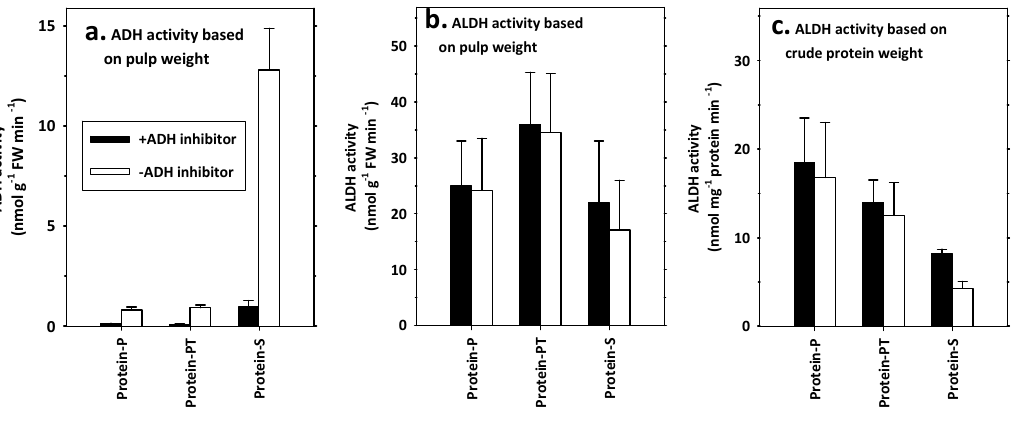
Figure 5. ADH and ALDH activity in crude proteins extracted from different fractions and effect of Triton X-100 (protein extraction enhancer) and 4-methyl pyrazole (ADH inhibitor). Proteins were extracted by ammonium sulfate precipitation from Tris buffer extraction of banana pulp tissues at the “yellow with brown flecks” stage. The activity was presented based on fresh sample mass ( a , b ) or protein mass ( c ). Protein-S: extraction from supernatant merged from 2 × Tris buffer extractions; protein-P: extraction from pellets was washed 2 × Tris buffer and solubilized by sonication; protein- PT: extraction from pellets after 2 × Tris buffer washing and solubilized by sonication with addition of Triton X-100. Vertical line at each column shows average ± SD (n =